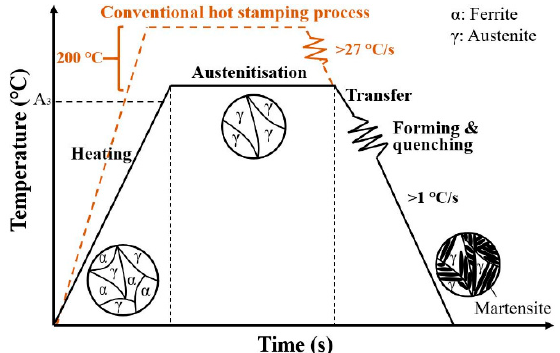
Figure 13. Schematic representation of low-temperature hot stamping of Medium-Mn steel and its microstructural evolution. The conventional hot stamping process is shown with dashed lines for comparison. Table 2. Reported tensile properties of some low-temperature hot stamped MMn steels. Ref.